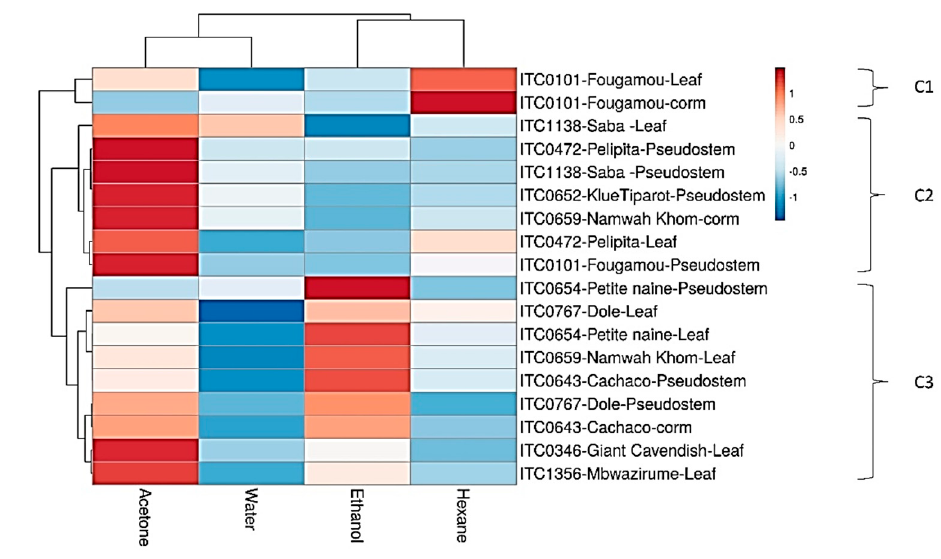
Figure 5. Heat map and clustering of Candida anti-biofilm activity of extracts from banana cultivars. C1–C3, Different clusters.